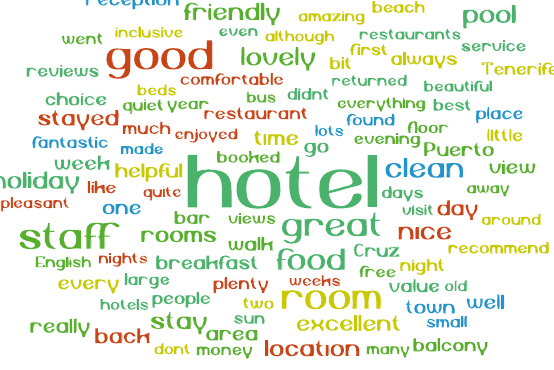
Figure 2: Positive review